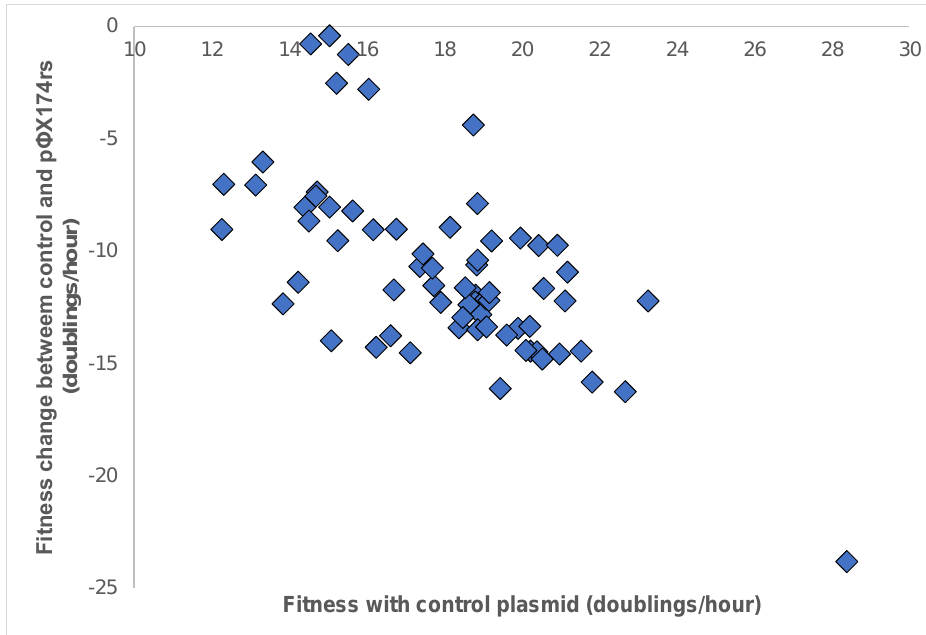
Figure 2. Fitness of phages grown in cells containing the control plasmid compared to the difference in fitness between growth in cells with the pΦX174rs plasmid and the control plasmid. Each point indicates the result of a single set of fitness assays. The weighted Spearman’s correlation analysis shows a moderate negative correlation (r = −0.65). To determine if there is a relationship between reduction sequence homology and fitness loss on the reduction sequence plasmid, sequence divergence of the wild phage strains from the ΦX174 reduction sequence was compared to fitness change using corre- lation analysis. Here, we show the average fitness change between control and the ΦX174 reduction sequence for each phage versus the percent divergence from the 495-base ΦX174 reduction sequence (Figure 3, Table 1). Divergence was found to be uncorrelated with fitness change, indicating no apparent association between a strain’s overall difference from the ΦX174 reduction sequence and its fitness under the ΦX174 reduction effect (r = 0.23, Spearman).